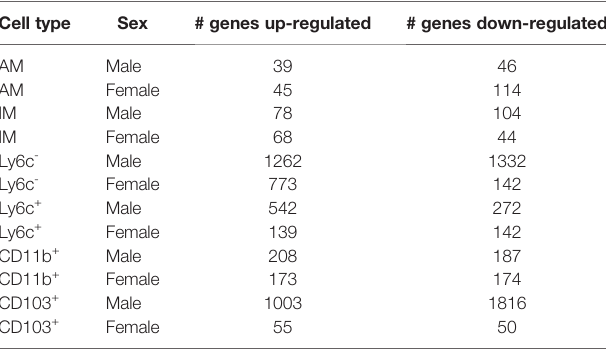
TABLE 1 | Genes Up- and Down-regulated After Incubation with C. neoformans . Cell